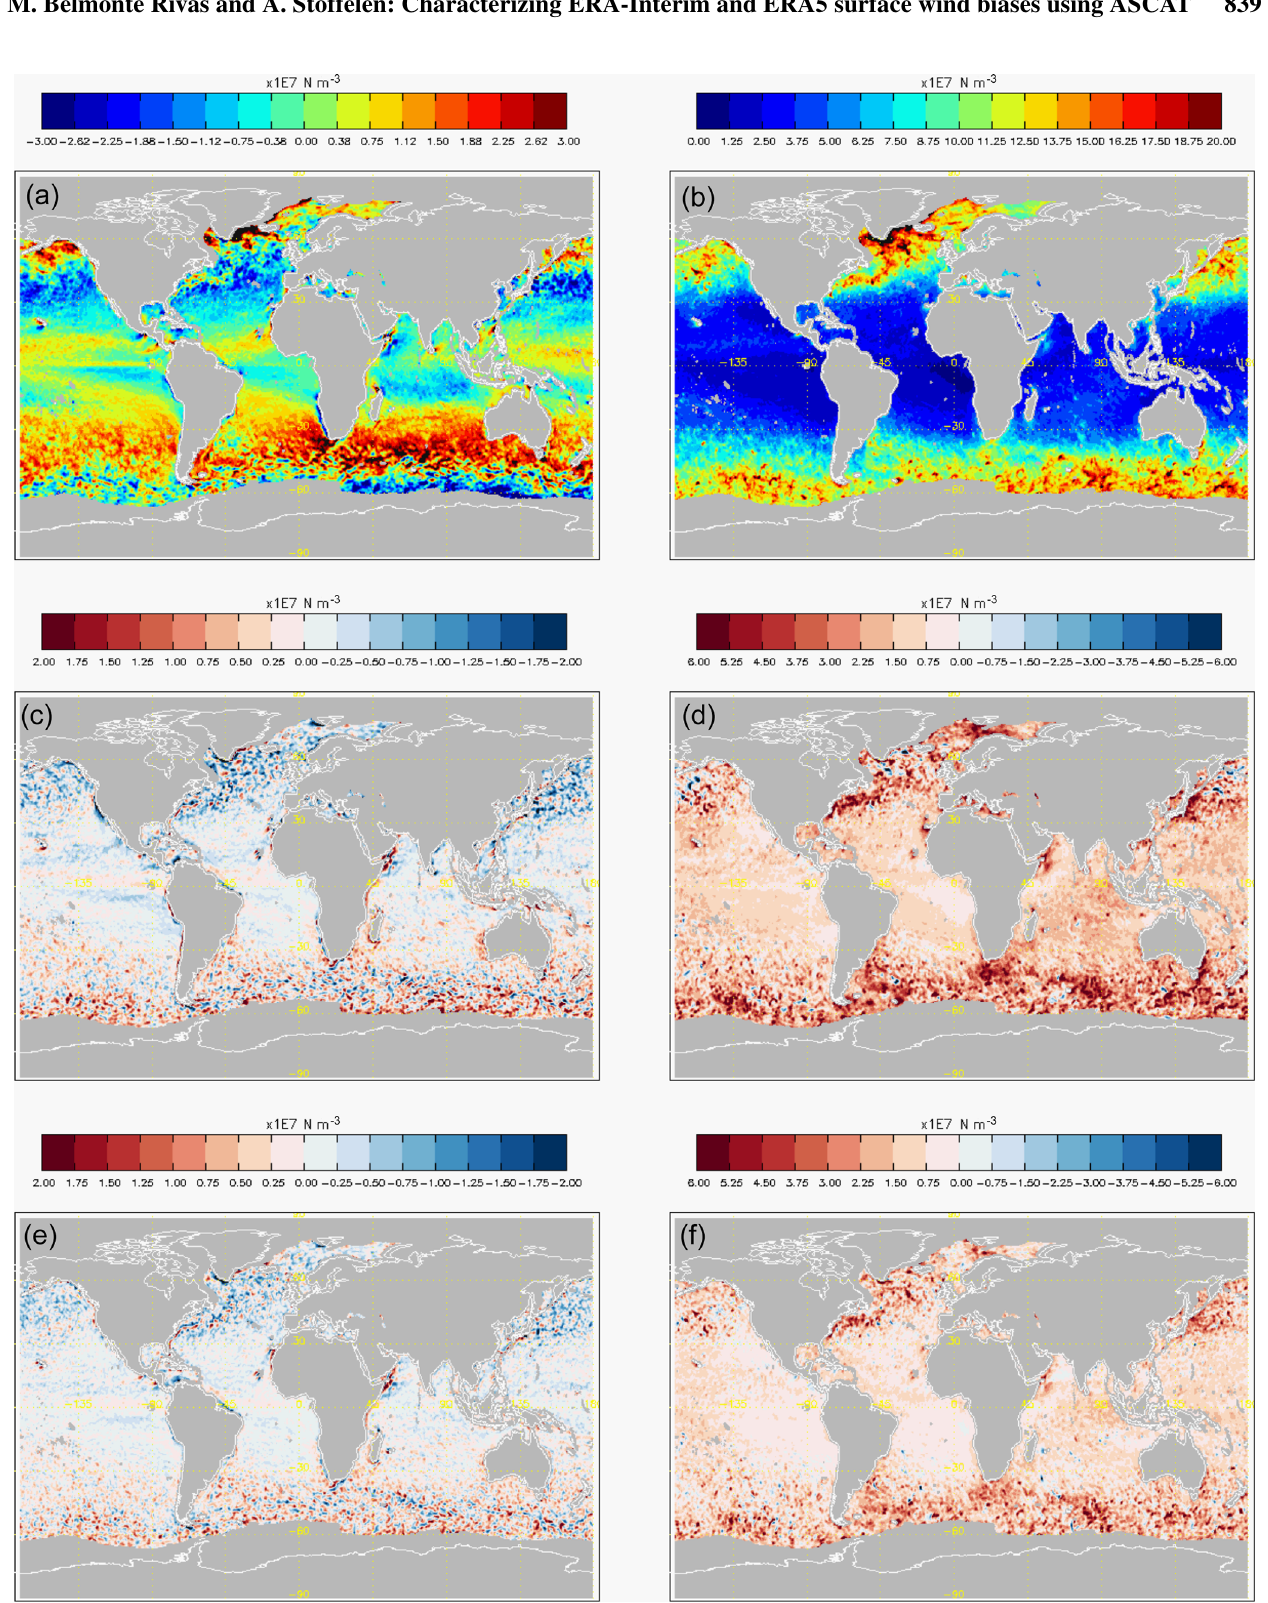
Figure 7. Global maps of annual mean (a) and eddy (b) stress curl from ASCAT and differences with ERA-Interim (c, d) and ERA5 (e, f) first-guess winds over 2016. Note the color scale